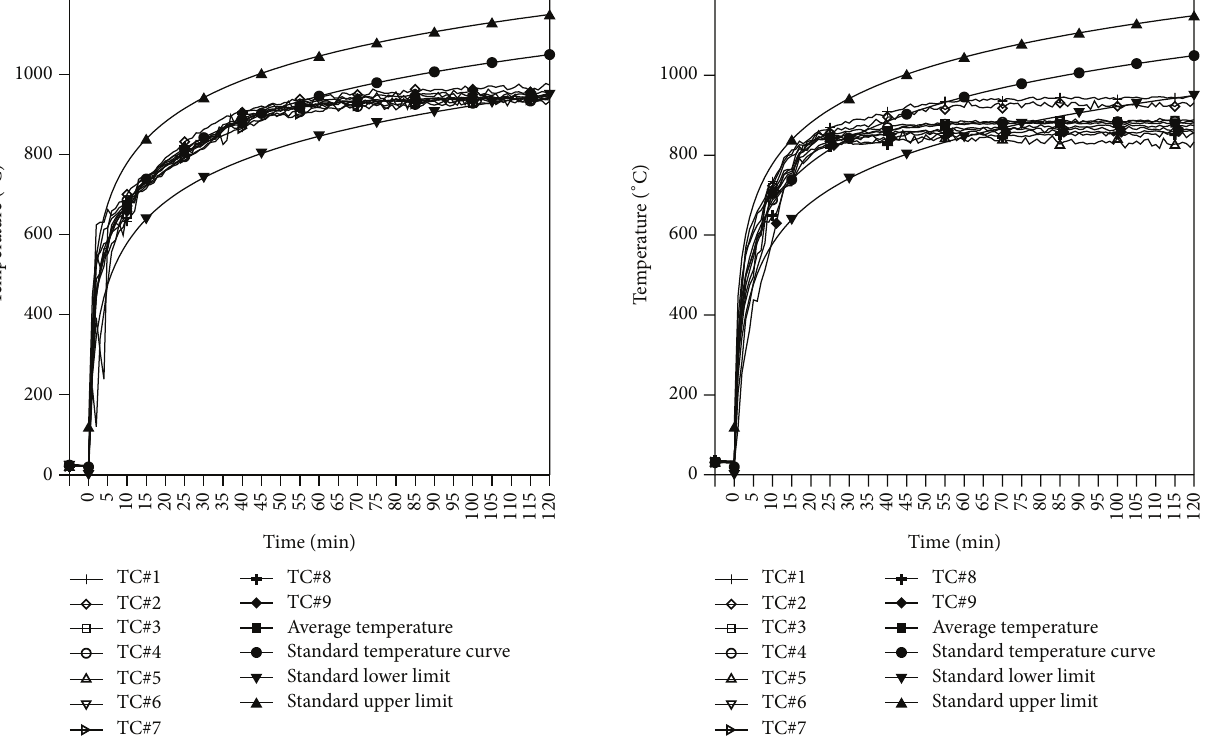
Figure 9: Temperature distributions of the interior furnace (water film on the unexposed surface).